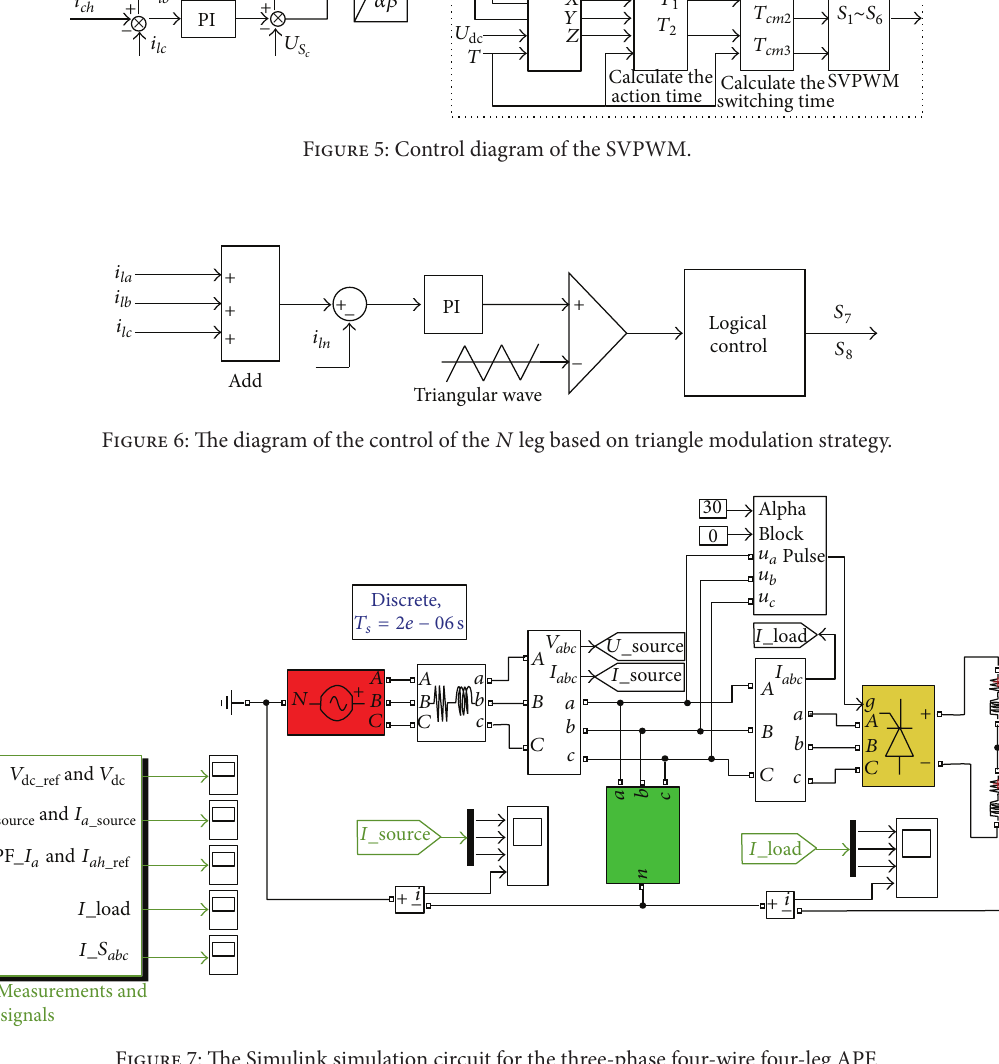
Figure 7: The Simulink simulation circuit for the three-phase four-wire four-leg